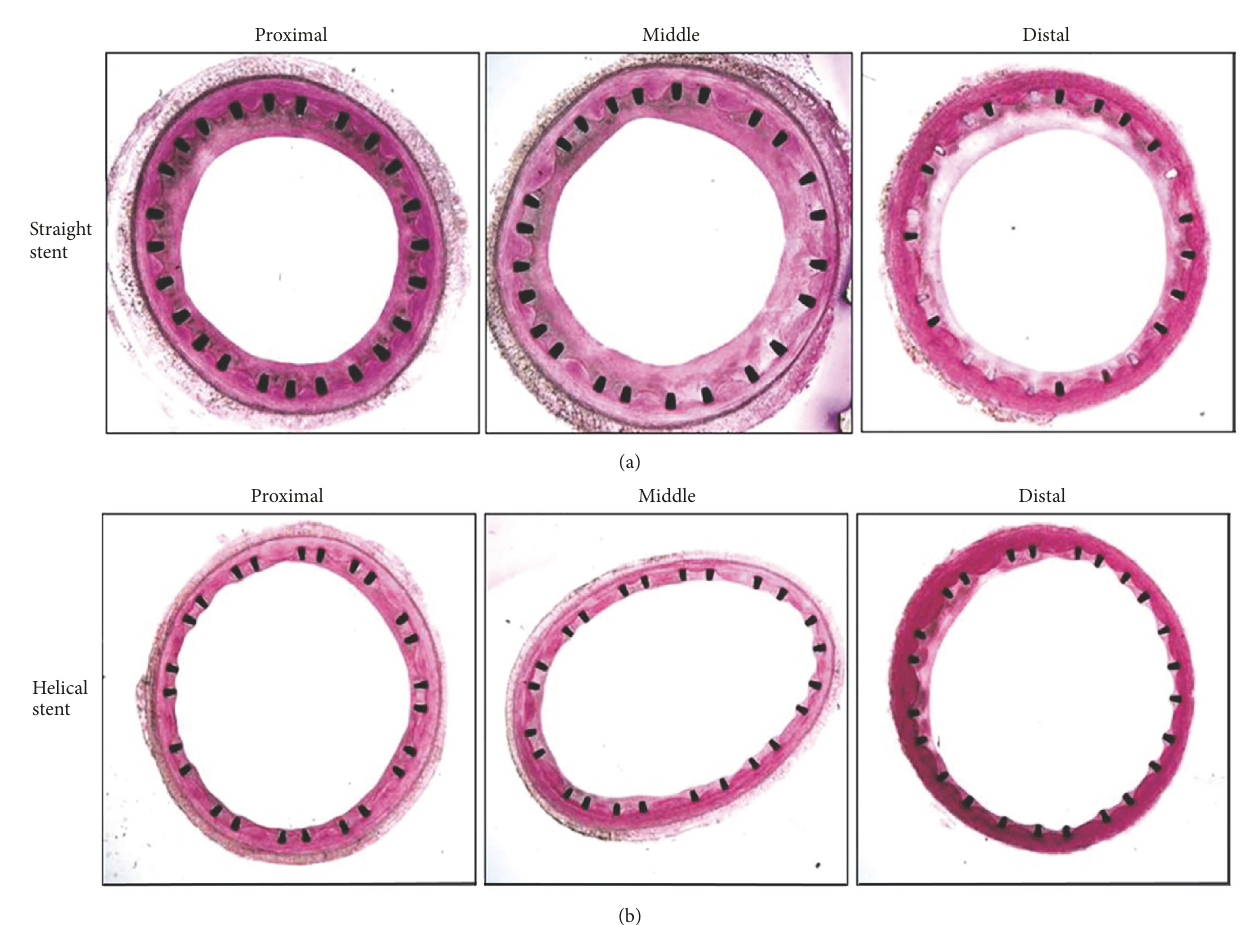
Figure 4: Transverse sections of porcine common carotid arteries treated with (a) a control straight stent and (b) the helical centerline stent at 1 month after stent deployment. From Caro et al. with permission